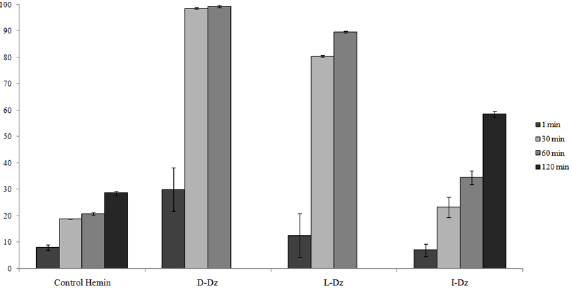
Fig 5. Oxidation of paracetamol using D, L and I-Dz. Percentage conversion to paracetamol oxidation products were measured at 1 min, 30 min and 60 min using D and L-Dz and at 1, 30, 60 and 120 minutes for